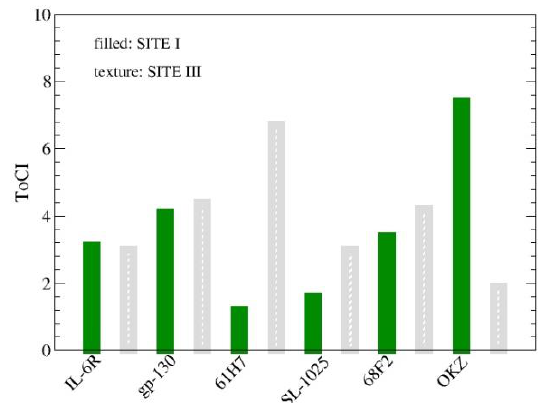
Figure 5. ToCI for the analyzed receptors of cytokine IL-6. The contacts are put on Site I (green), which is the natural binding site for all the listed receptors but olokizumab (OKZ), which has Site III as the natural binding site. Largest differences between the two Sites are observed for the humanized Fab 61H7, while for the natural receptors (IL-6R, gp-130), which are arranged symmetrically, with respect to the two sites (see Figures 3 and 4), the differences are tiny.